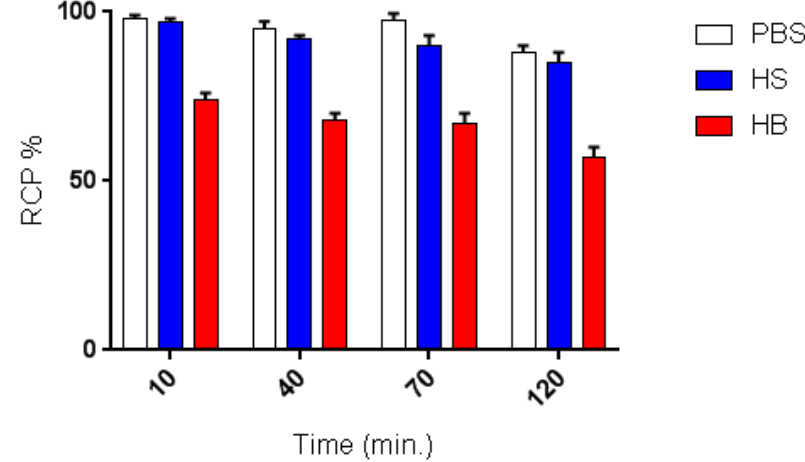
Figure 5. Stability of 68 Ga-DOTA-C21 complex incubated over time (10, 40, 70, 120 min.) in different media ( n = 3, mean ± media ( n = 3, mean ± SD).